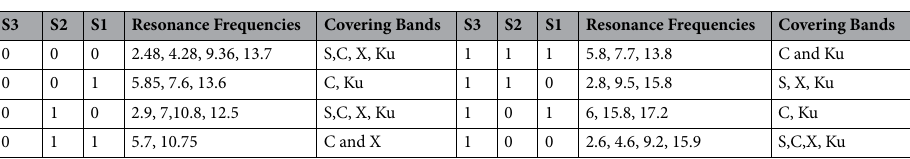
Table 4. Resonances and covering bands of the proposed MTM unit cells for switching positions. S1, S2, and S3 indicate three open, and short circuit switches across the three outer rings split gaps.